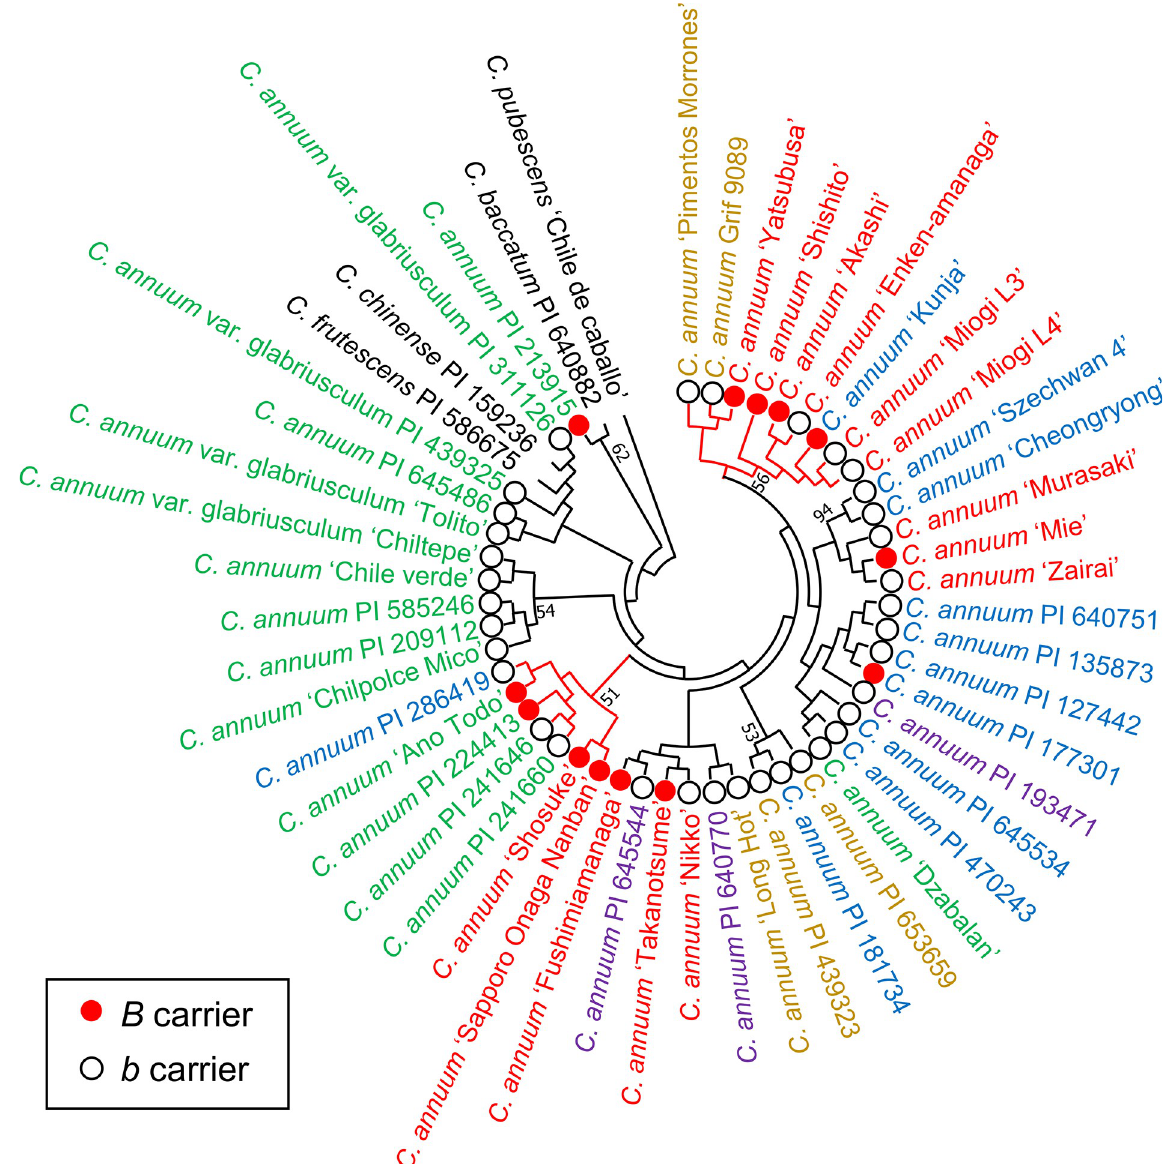
Fig 2. Phylogenetic UPGMA trees of 48 accessions of C . annuum with 4 other species based on 34 SSR markers. B or b carriers are indicated as red or white circles, respectively. The branches in the clade with high percentage of B carriers are shown in red.